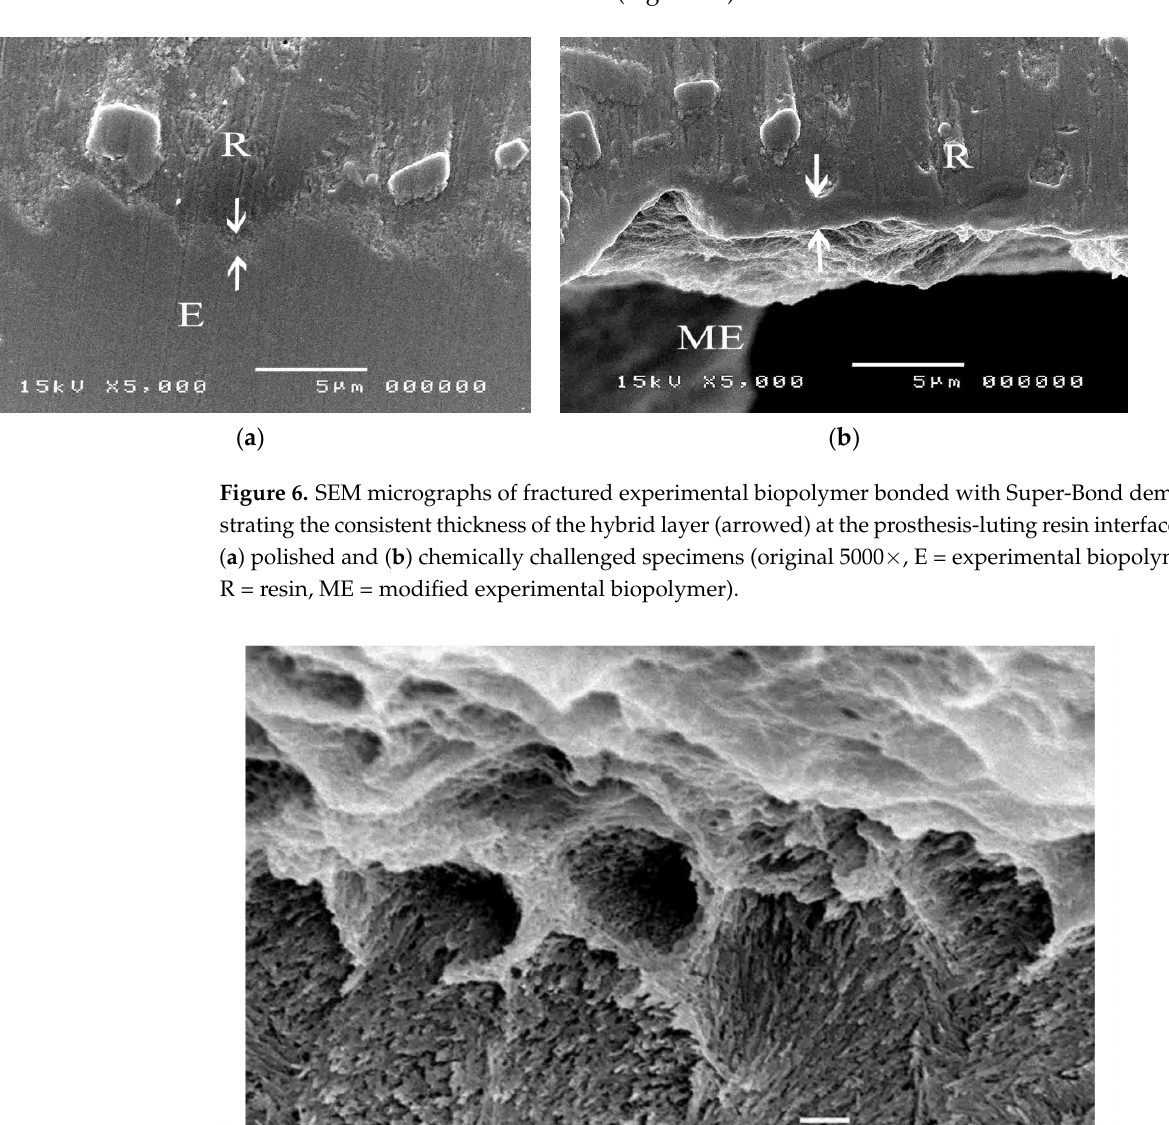
Figure 5. Mixed failure of cohesive failure in resin (R) and adhesive failure on the prosthesis side interface (A) on fractured specimens of ( a ) experimental biopolymer bonded with All-Bond2 + Du- oLink and ( b ) ceramic bonded with Super - Bond ( original ×20).